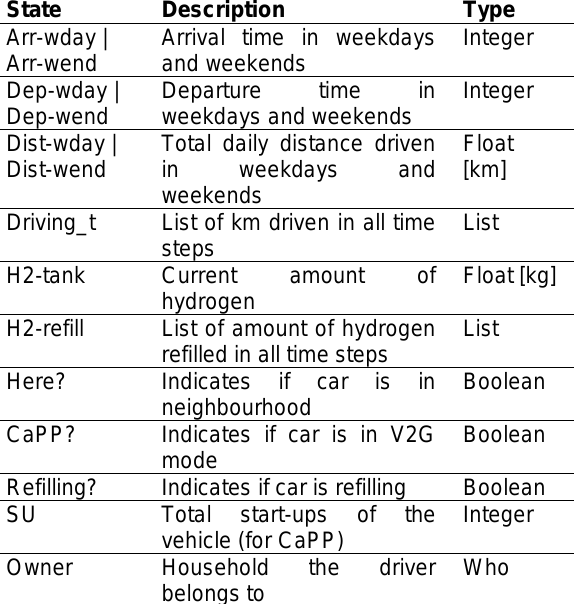
Table 2. FCEV agent states